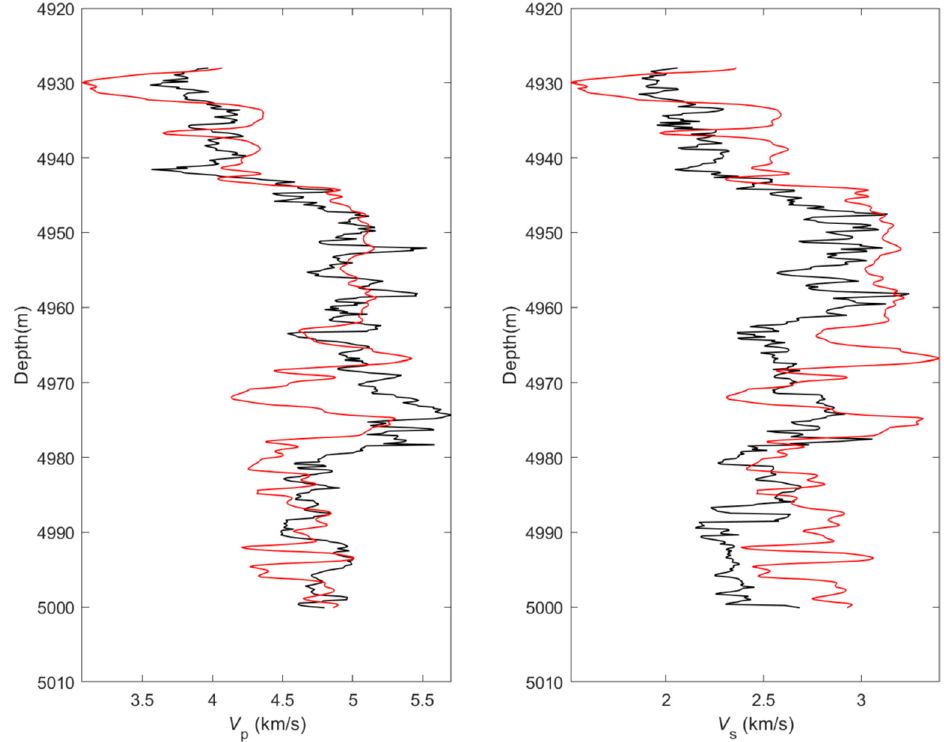
Figure 5. The prediction of P-wave and S-wave velocities based on Han’s empirical formula (red is the predicted velocity, black is the actual velocity).